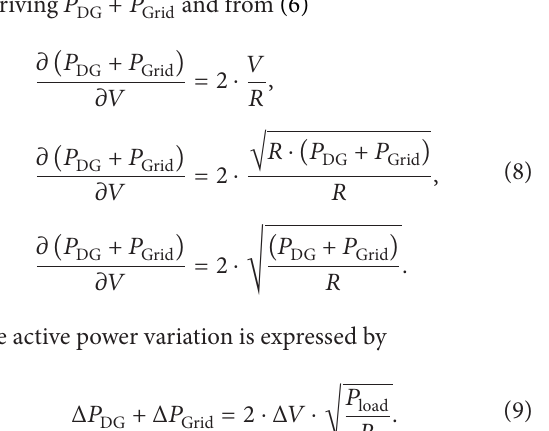
𝑉 . The 𝑉 will same constant voltage (184.8 V) for three PCC PCC